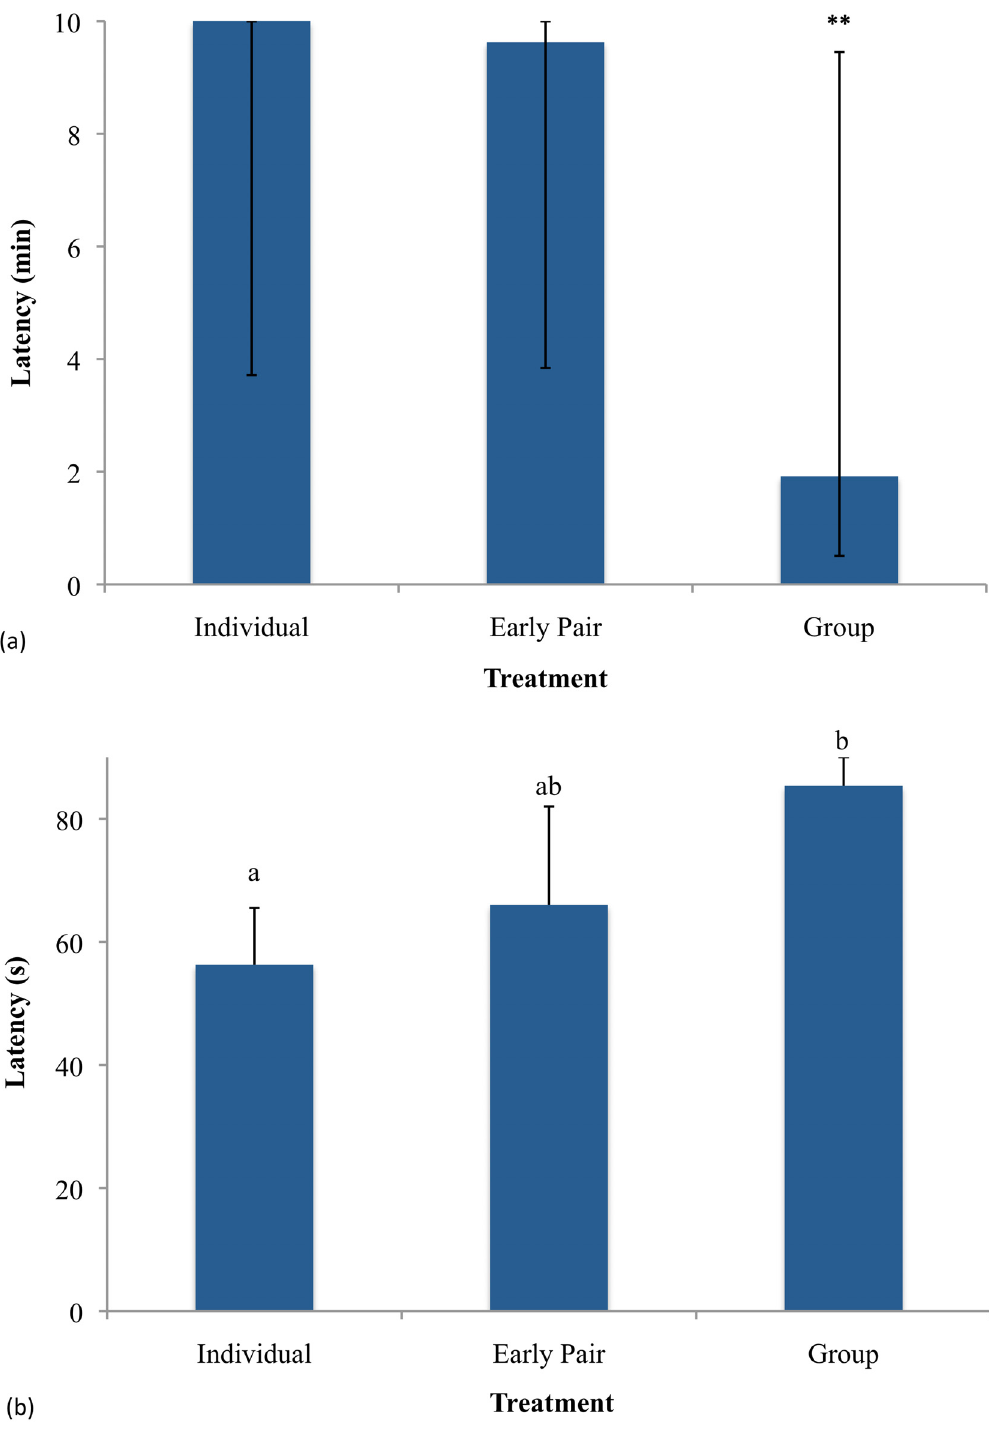
Fig 4. Response of calves to anxiety tests at approx. 40 – 41 d of age. n = 22 Individual, 13 Early Pair, 9 Group. (a) Latency to touch a novel object was lowest in group-housed calves at approx. 40 d of age . Values are medians with interquartile ranges (maximum value of 10 min assigned to calves who did not make contact). ** indicates a treatment that significantly differs from the others at P < 0.05. ( b) Latency of calves to touch a familiar human in a handling test was higher in group-housed than in individually housed calves at approximately 41 d of age . Values are means + SE (maximum value of 90 s assigned to calves who did not make contact). Treatments that do not have the same letter differ from each other at P < 0.05.